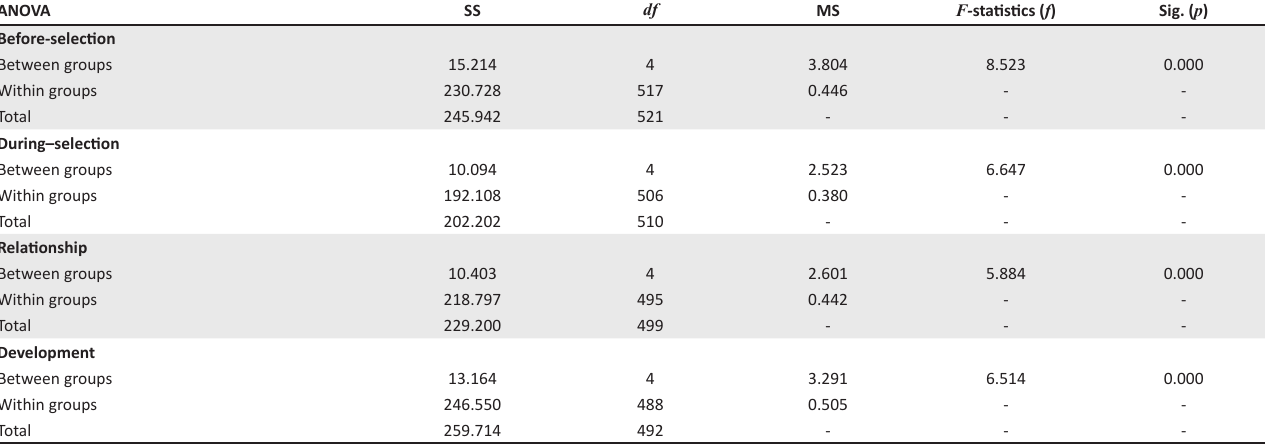
TABLE 6: Analysis of variance comparison between managerial level groups. ANOVA